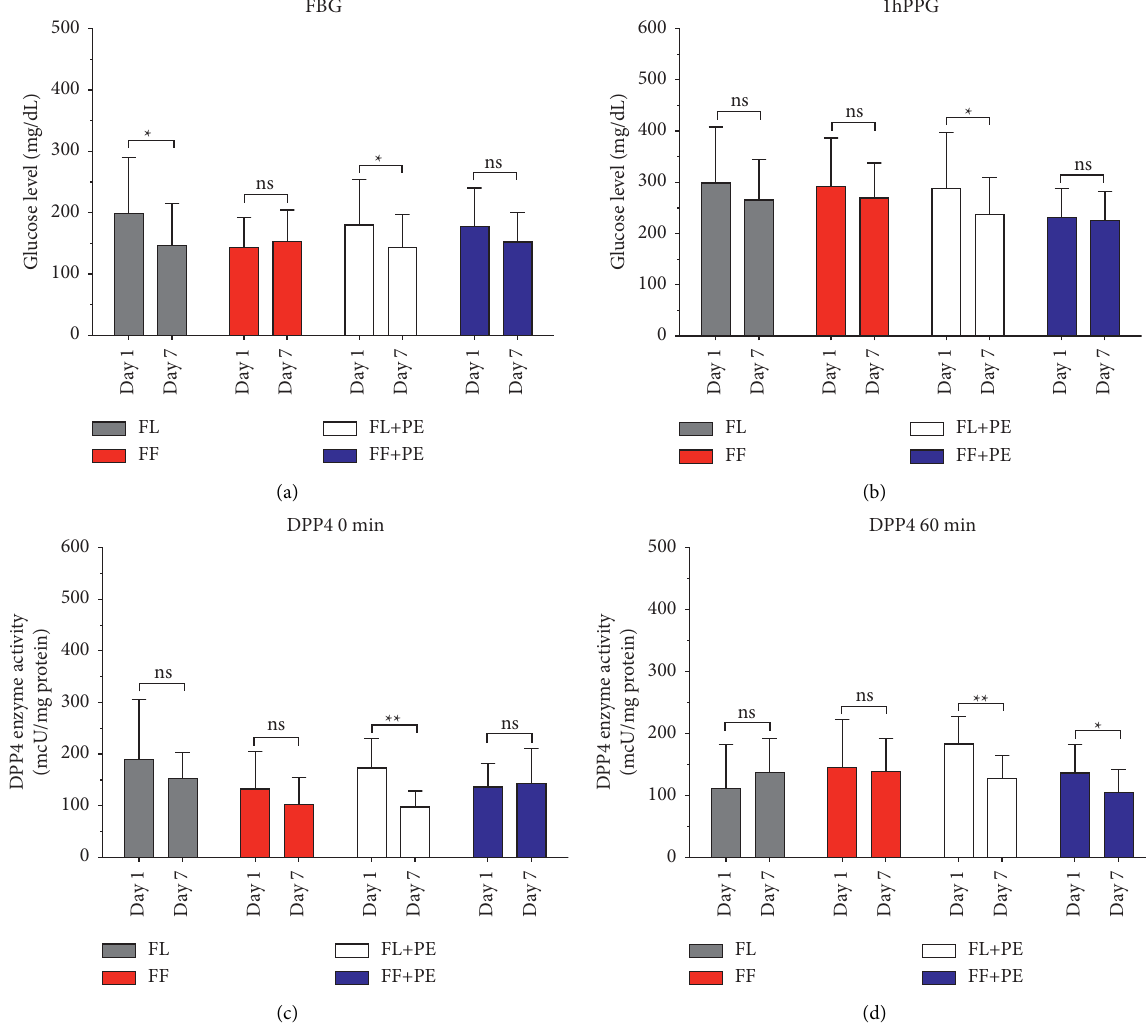
Figure 2: (a) Fasting blood glucose (FBG) level on day 1 and day 7 of a 7-day course of treatment; (b) one-hour postprandial glucose (1h PPG) level on day 1 and day 7 of a 7-day course of treatment; (c) fasting DPP4 activity; and (d) 1h DPP4 activity on day 1 and day 7. ns � non-signifcant, ∗ p < 0 .